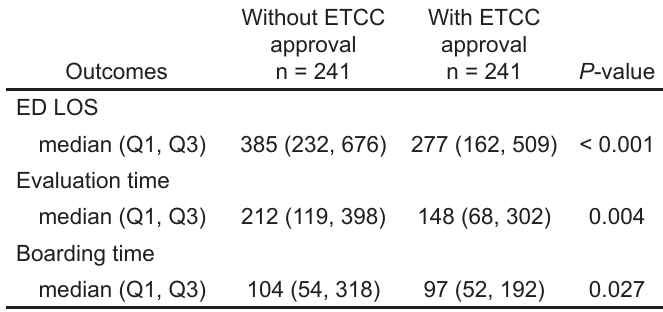
Table 2. Comparison of outcomes between two groups in the matching population